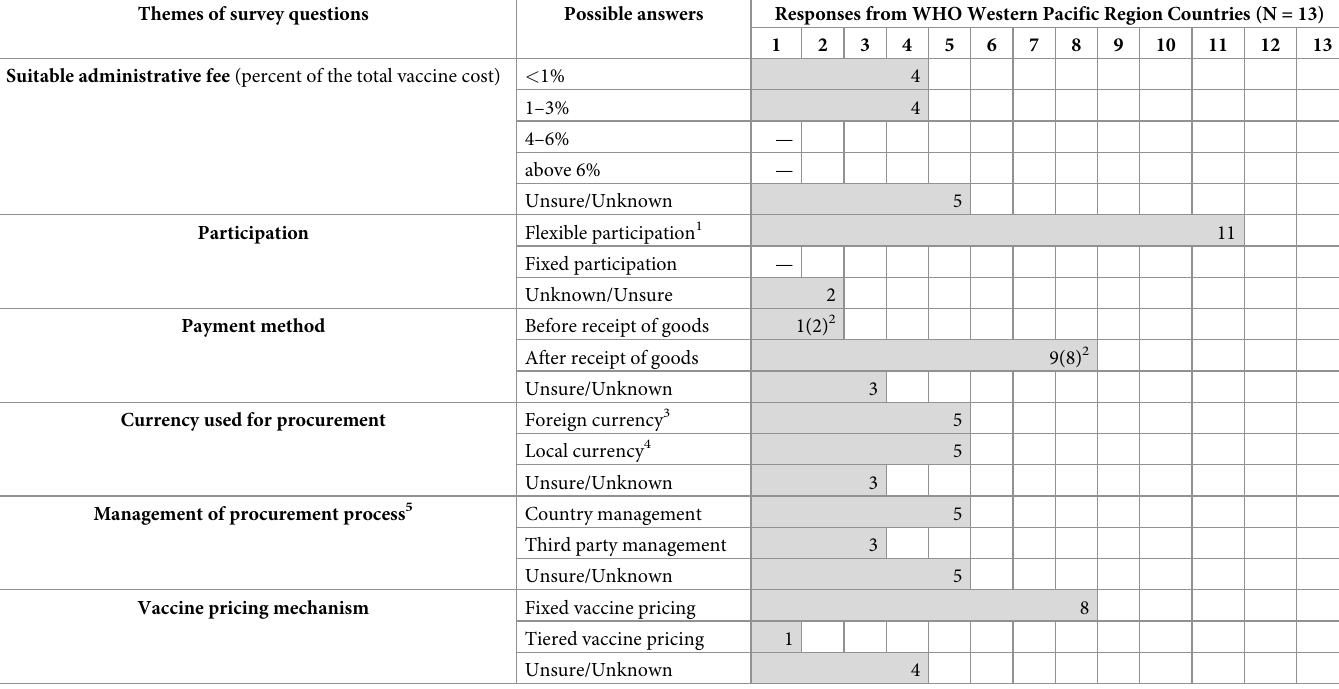
Table 2. Summary of preferred characteristics for a regional pooled procurement mechanism in the World Health Organization (WHO) Western Pacific